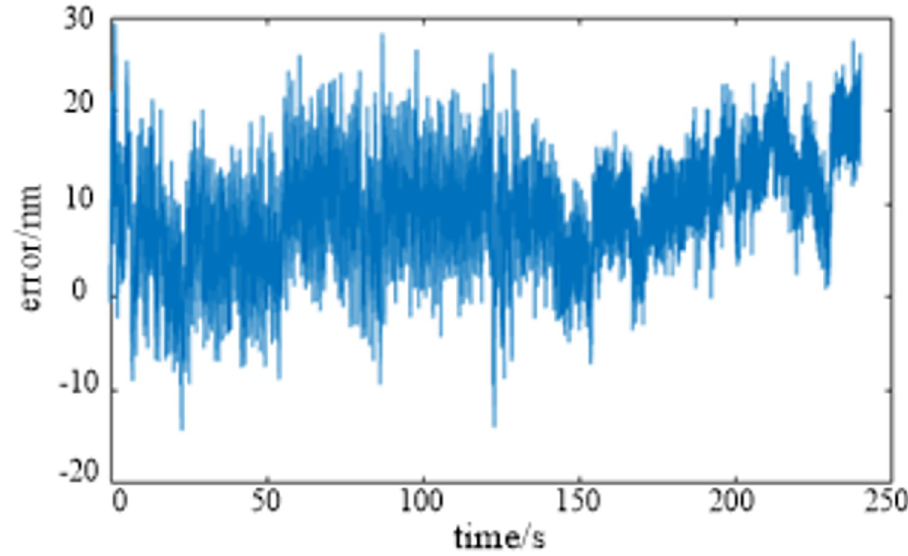
Fig 10. The curve of path tracking error.